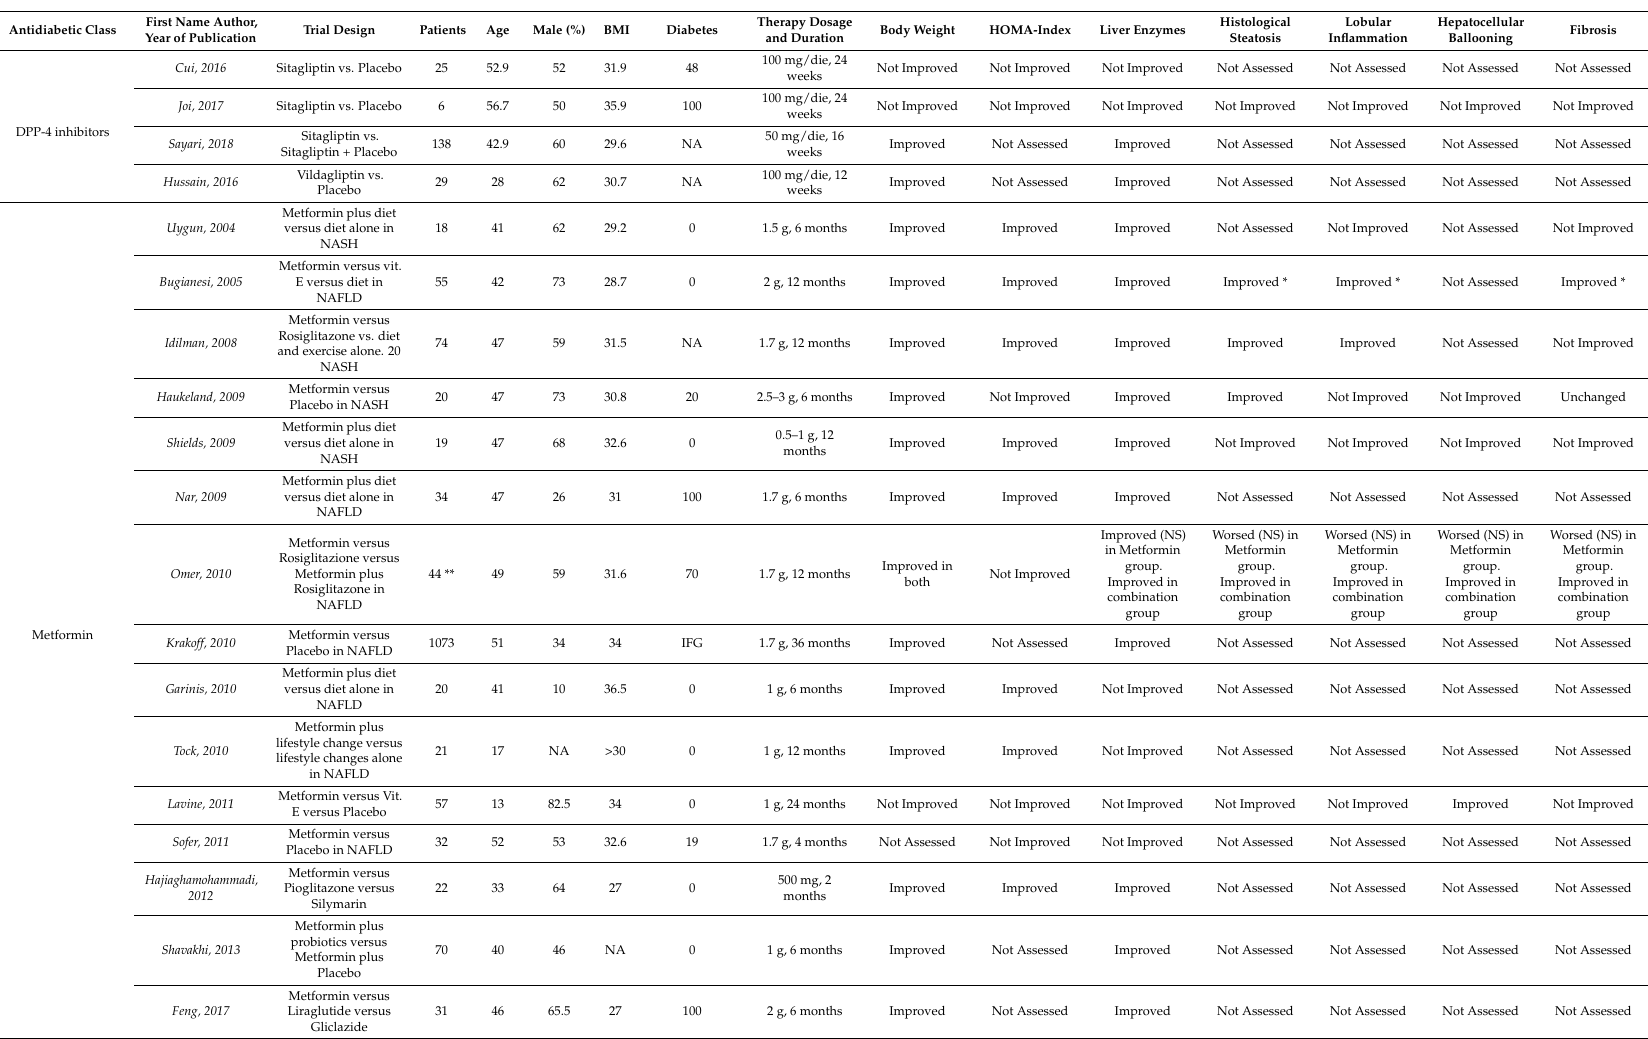
Table 1. Studies assessing the effect of antidiabetic drugs on metabolic and liver outcomes in patients with nonalcoholic fatty liver